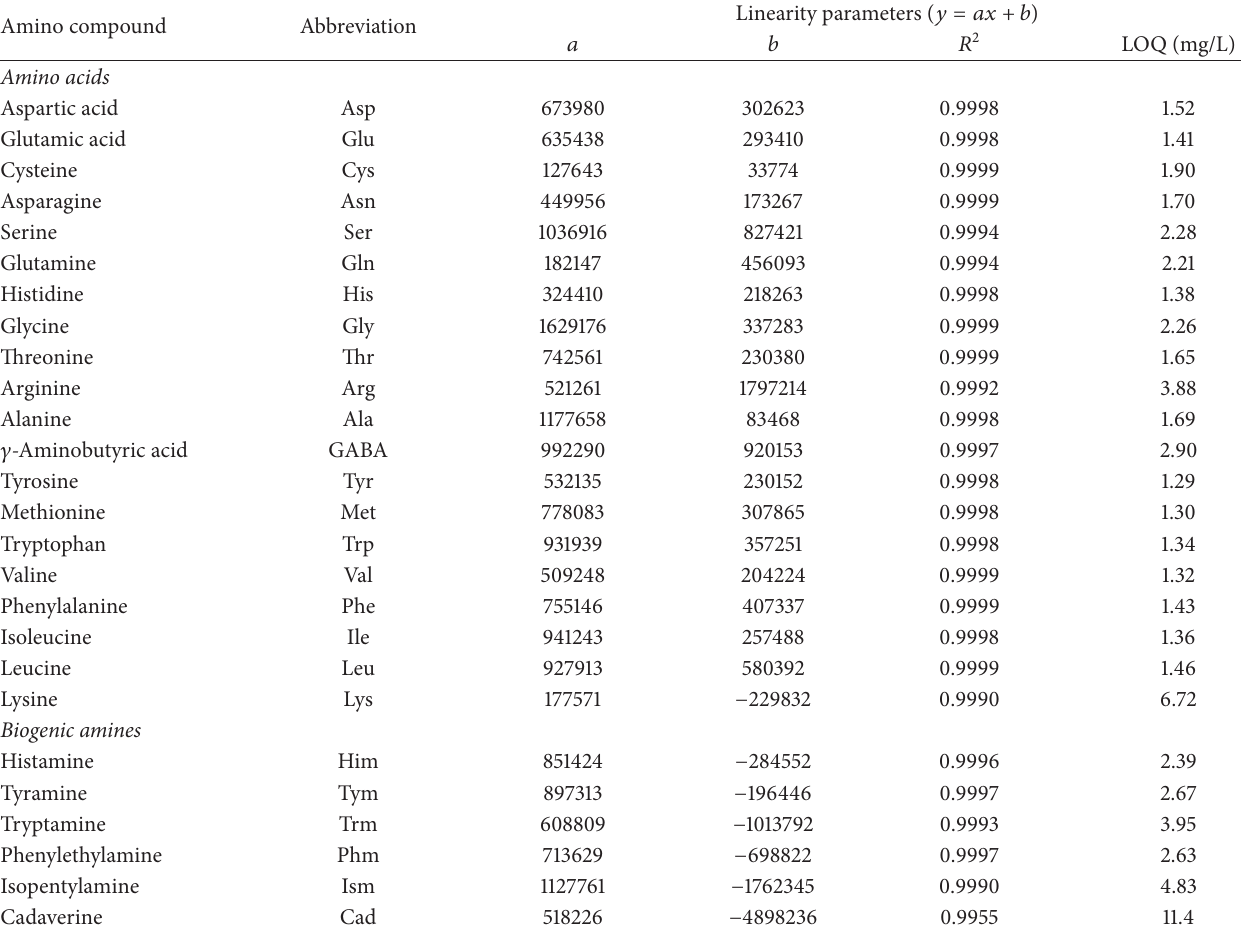
Table 1: Summary of the linearity parameters obtained for the in-loop IDA/OPA/MCE derivatization procedure occurring in the HPLC-FLD system. The working concentration range varied between 3 and 125 mg/L. LOQ was calculated on the basis of the linear regression 𝑦 = 𝑎𝑥+𝑏 , according to LOQ = 10𝜎/𝑎 , where 𝜎 is the 𝑦 -intercept standard deviation and 𝑎 the